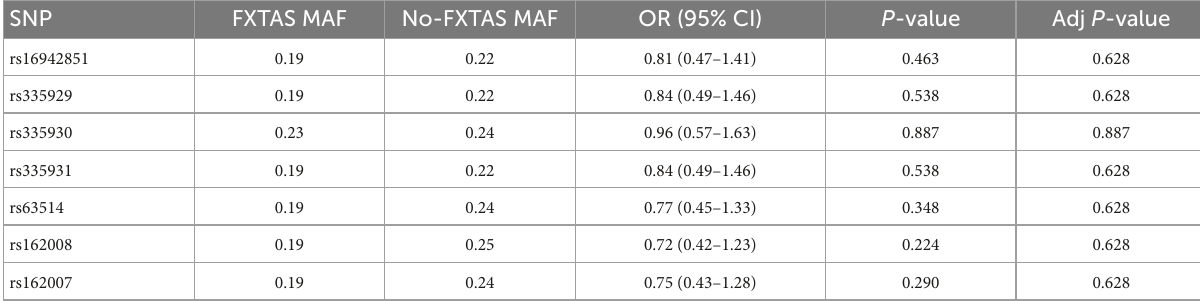
TABLE 3 Single nucleotide polymorphism (SNP) allele association